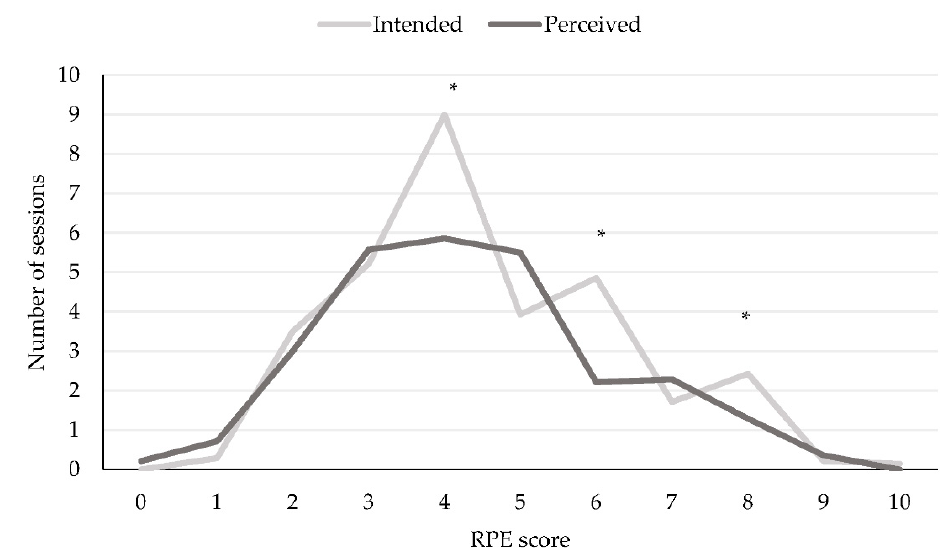
Figure 1. Intended and perceived RPE distribution over all sessions. *: p < 0.05.